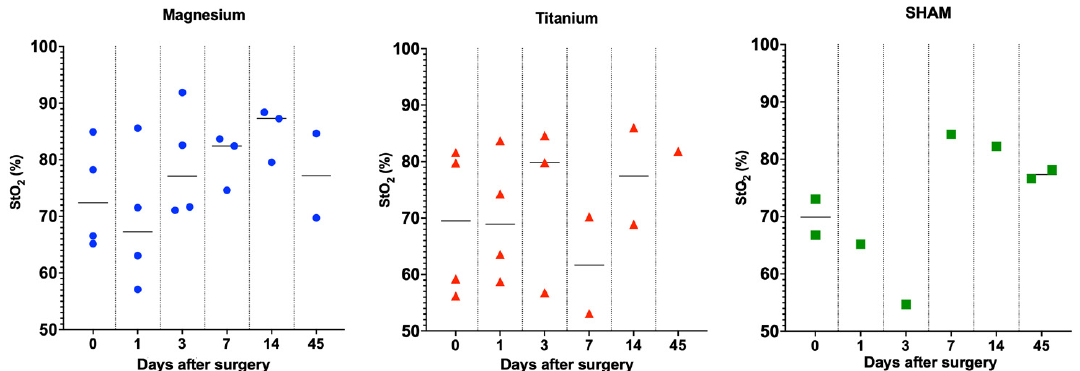
Figure 4. The tissue oxygen saturation (StO 2 %) values calculated for each animal for all timepoints (0, 1, 3, 7, 14, 45) are represented in the distribution plot.